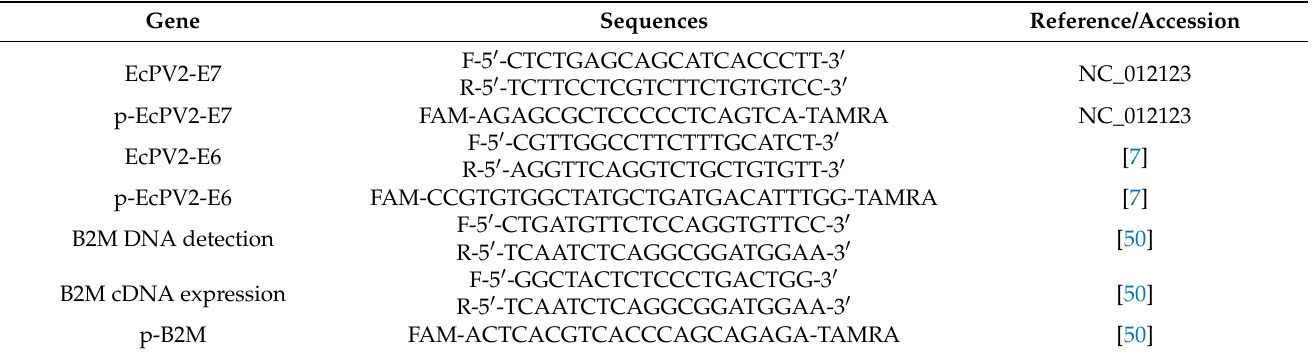
Table 3. Probes and primers sets used to evaluate EcPV2 presence and expression.